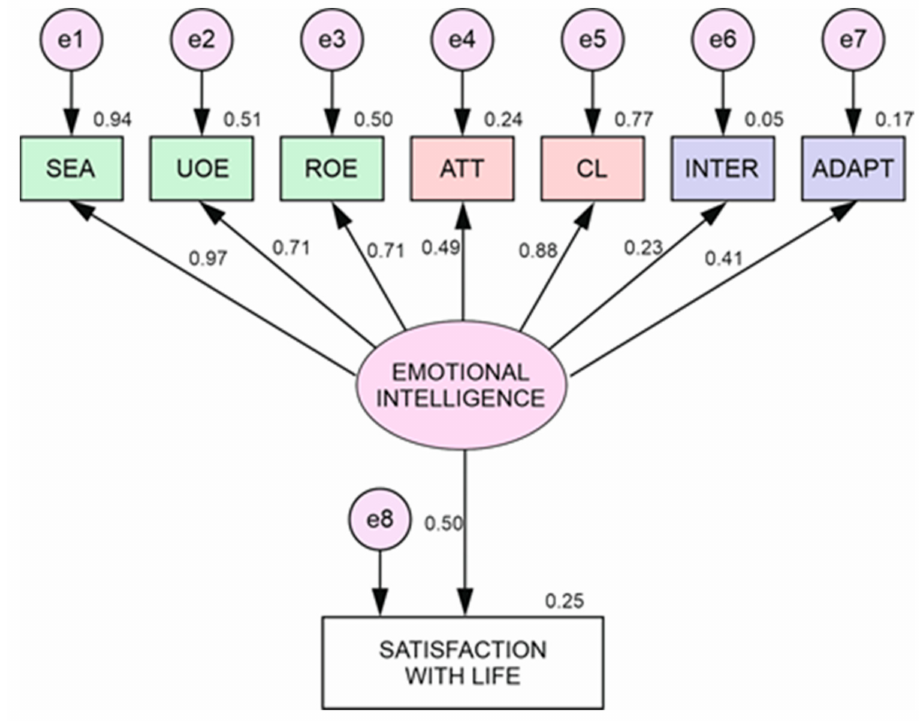
Figure 2. Multi-group structural equation model for women. Table 6. Regression weights and standardized regression weights for